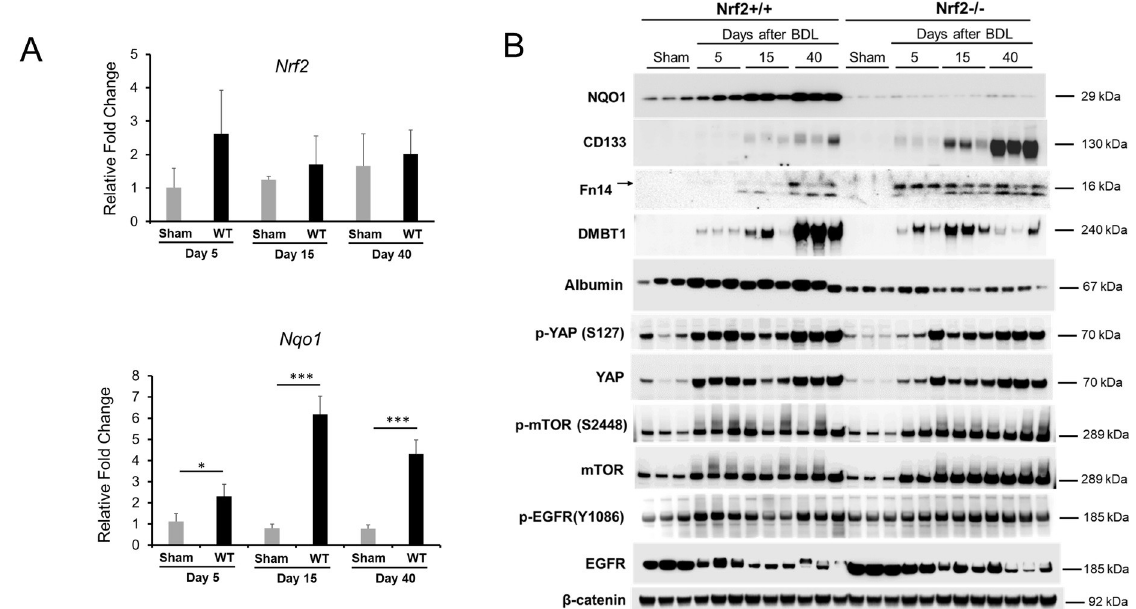
Fig 6. Hepatic expression of a group of genes or proteins in Nrf2 +/+ and Nrf2 -/- mice after bile duct ligation (BDL). (A) mRNA expression of hepatic Nrf2 and Nqo1 was quantified by qRT-PCR. (B) Western blotting was performed with antibodies against the proteins indicated. Liver lysates were prepared from the livers of mice after BDL or sham operation. β -catenon was used as a loading control because it showed the most stable expression over the course of cholestasis relative to regular loading controls screened. Each lane represents a sample from an individual mouse. � P < 0.05; �� , P < 0.01; ��� , P <